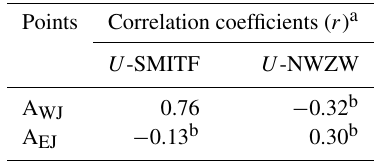
Table 1. Correlation coefficients between zonal currents at 100m depth at both A WJ and A EJ and both the local NW zonal wind and subsurface (200m) maximum ITF in the southern Ombai Strait dur- ing DJF in the period of 2004 through